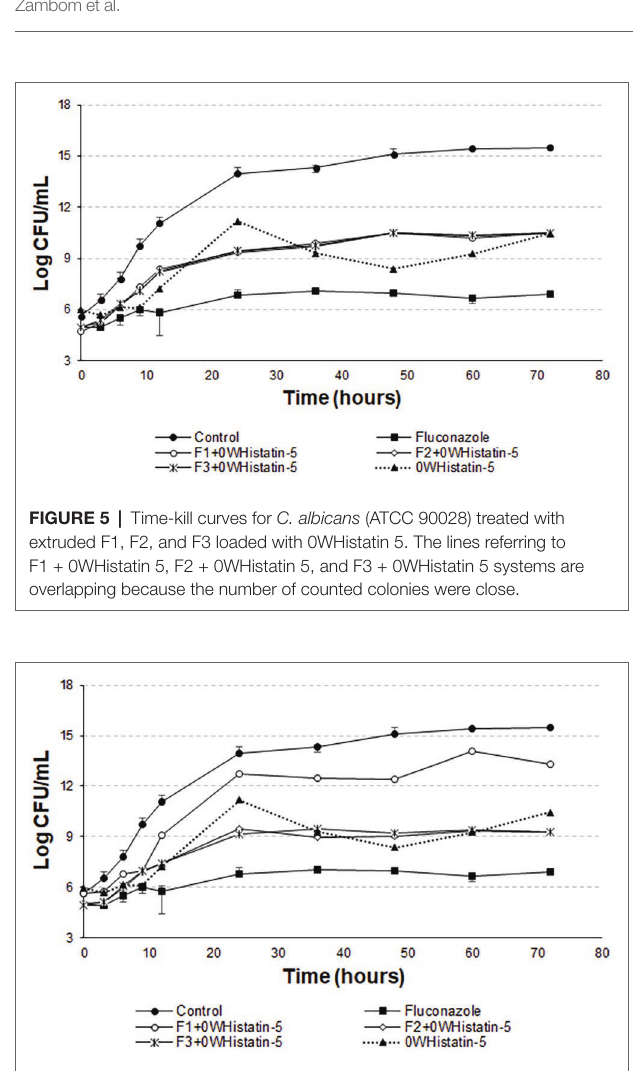
FIGURE 6 | Time-kill curves for C. albicans (ATCC 90028) treated with sonicated F1, F2, and F3 loaded with 0WHistatin 5. The lines referring to F2 + 0WHistatin 5and F3 + 0WHistatin 5 systems are overlapping because the number of counted colonies was close.